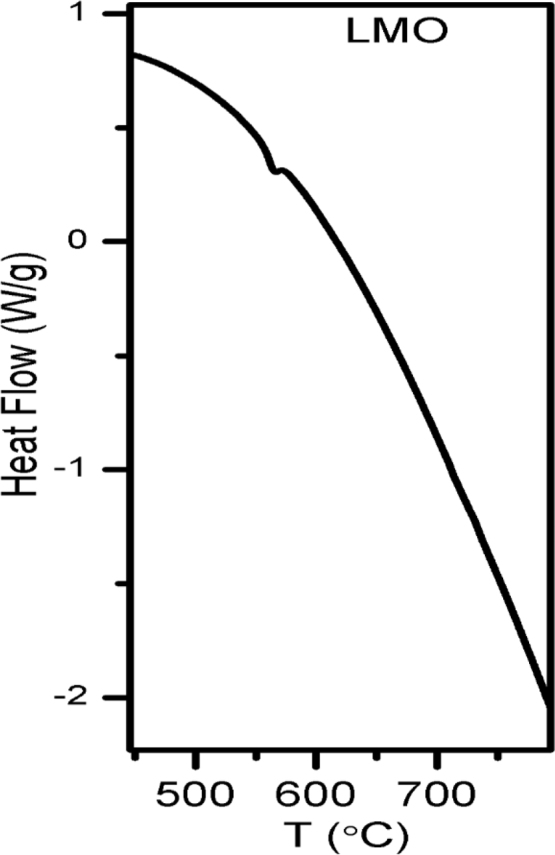
TG/DTA thermogram for bulk La2Mo2O9.